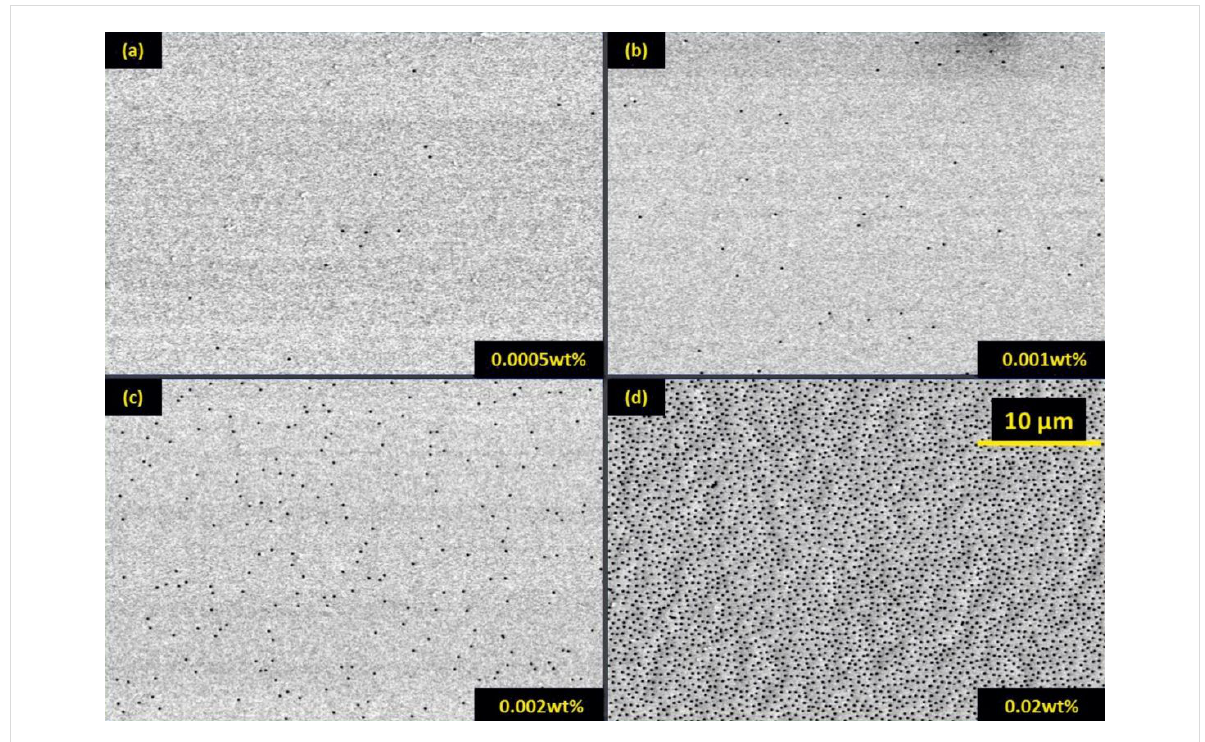
Figure 3: SEM images of gold masks with different concentrations of PS spheres (shown in the lower-right corners). The PDDA concentration was 0.05 wt % for (a) and (b), 0.1 wt % for (c), and 0.2 wt % for (d). The wavy structure in Figure 3d is indicative that a sufficient oxygen plasma etching time has been reached. PS nanospheres of 119 nm diameter were used in all four